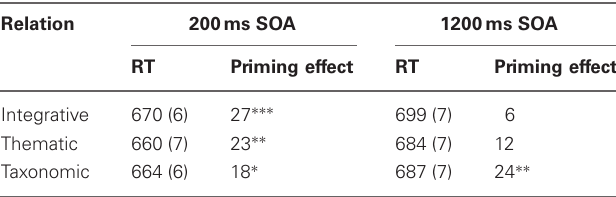
Table 2 | Study 1, Adjusted Means and (SEs) of Target RTs (ms) and Priming Effects